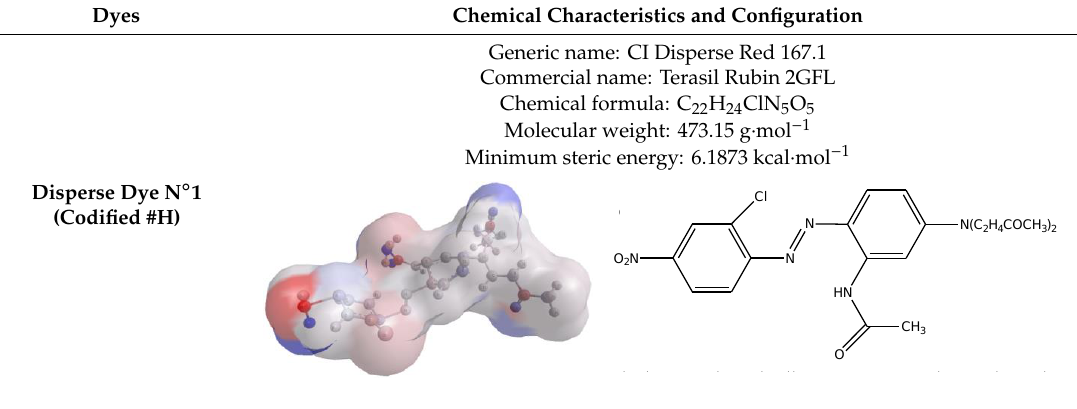
Table 2. Chemical characteristics and configuration of studied disperse dyes.